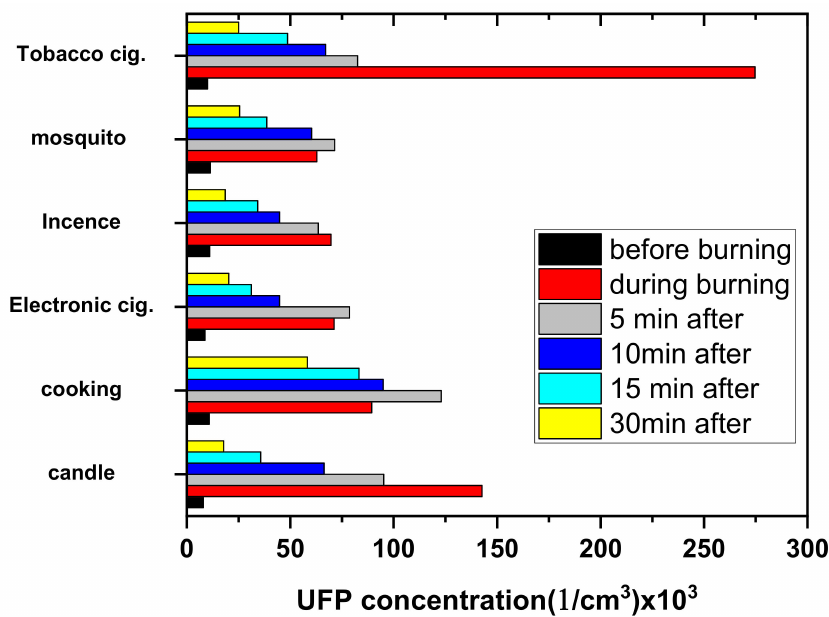
Figure 3. Ultrafine particle number concentration (<200 nm) for six indoor aerosol sources (candles, cooking, electronic cigarettes, tobacco cigarettes, mosquito coils and incense) at different times (before being turned on, during operation and after being stopped).